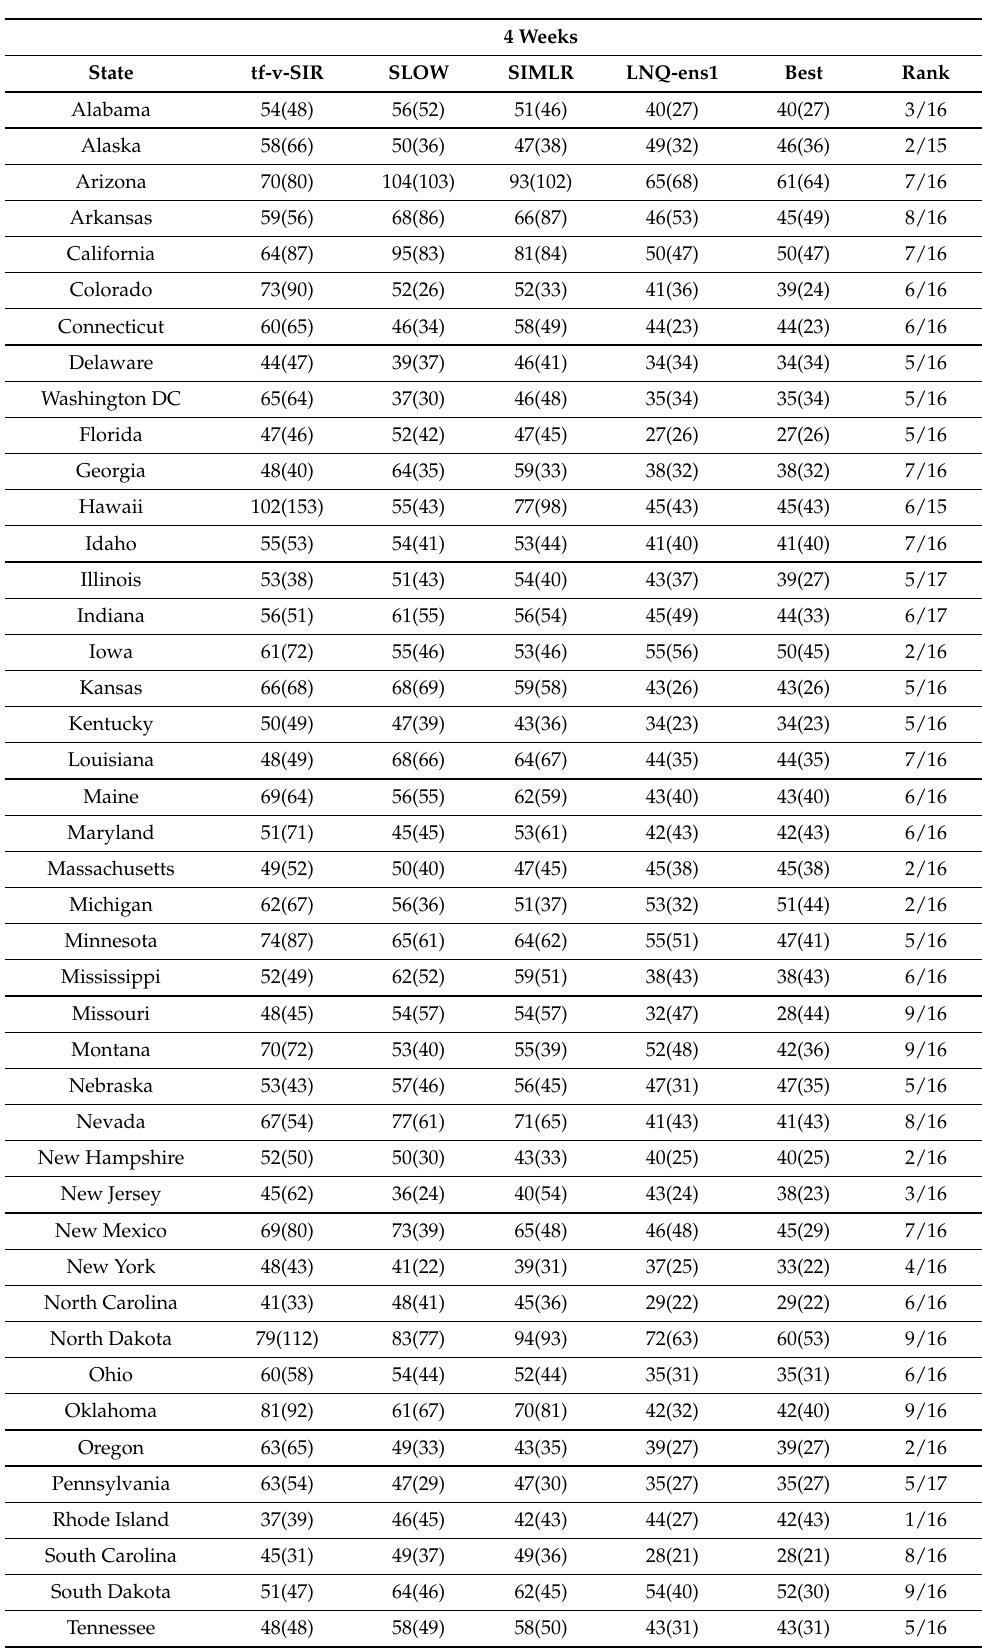
Table A4. Comparison of MAPE between different models across all the states in the US 4 weeks in advance. The number in parenthesis represents the standard deviation of the